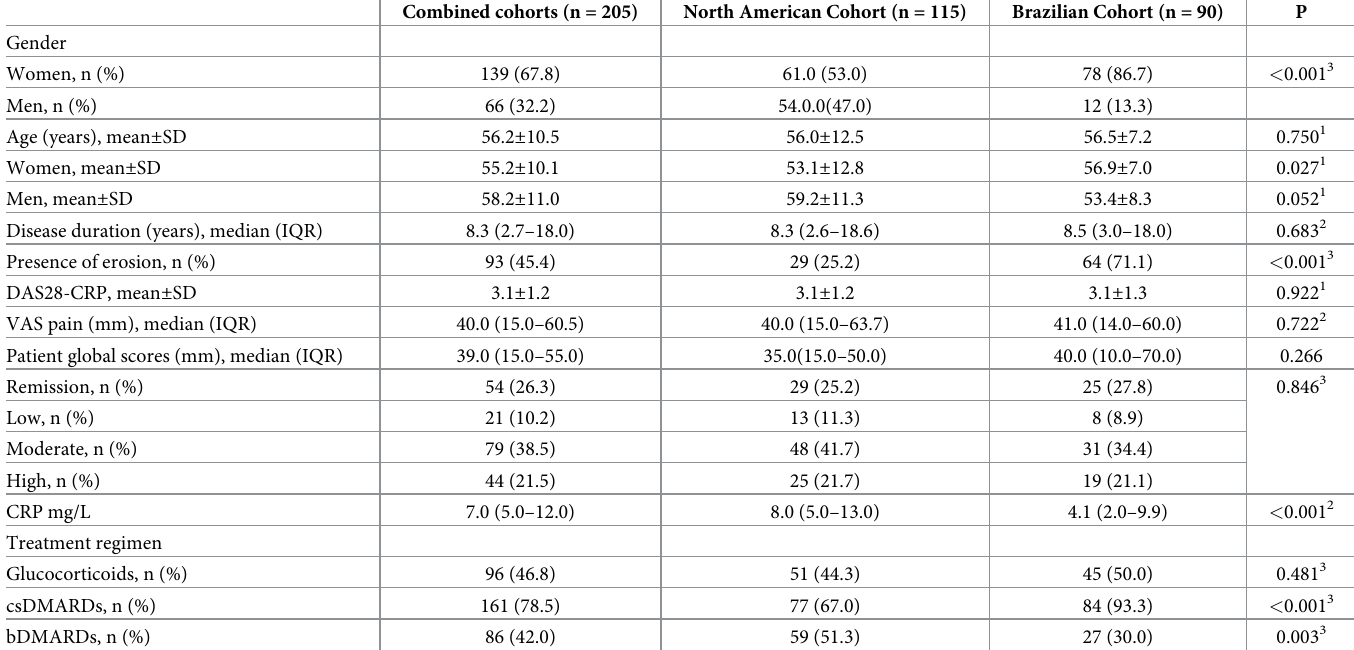
Table 1. Basic characteristics of the two study